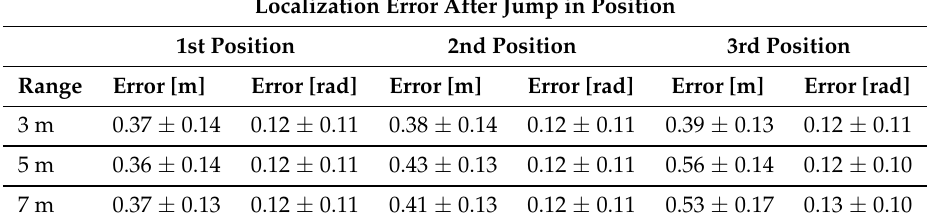
Table 3. Localization error: Sensor model errors that had a jump in their position at three different timesteps in three different